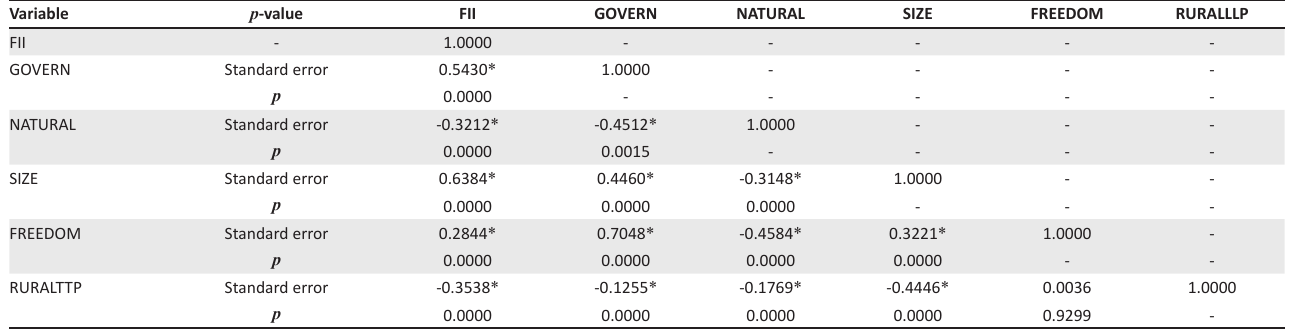
TABLE 5: Results of correlation analysis.